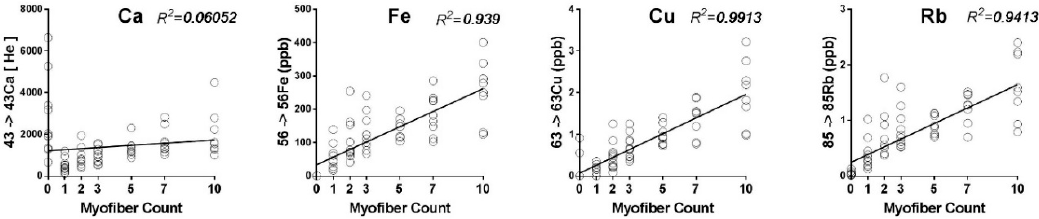
Figure 1. Basal concentrations (ppb) of 7 elements in samples of EDL fibers equilibrated in a standard (Rb-free) Tyrode’s solution. All measurements were performed simultaneously in a multi-well plate. Each symbol represents one sample from one well. Each sample contained 1–10 fibers. 3–6 samples were processed for each element and fiber count. Solid lines: linear regression fit to each data set.